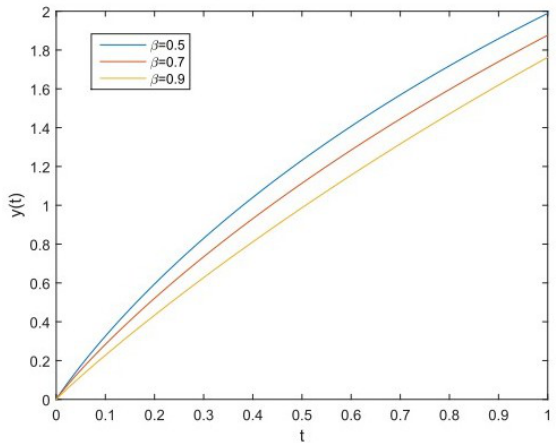
Figure 2. Dynamics of a sphere in an incompressible viscous fluid (Fixed α )